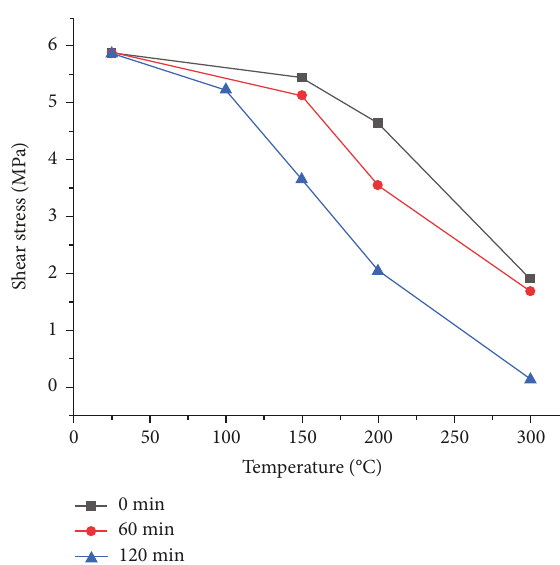
Figure 7: Relationship between ultimate shear stress and heating temperature.